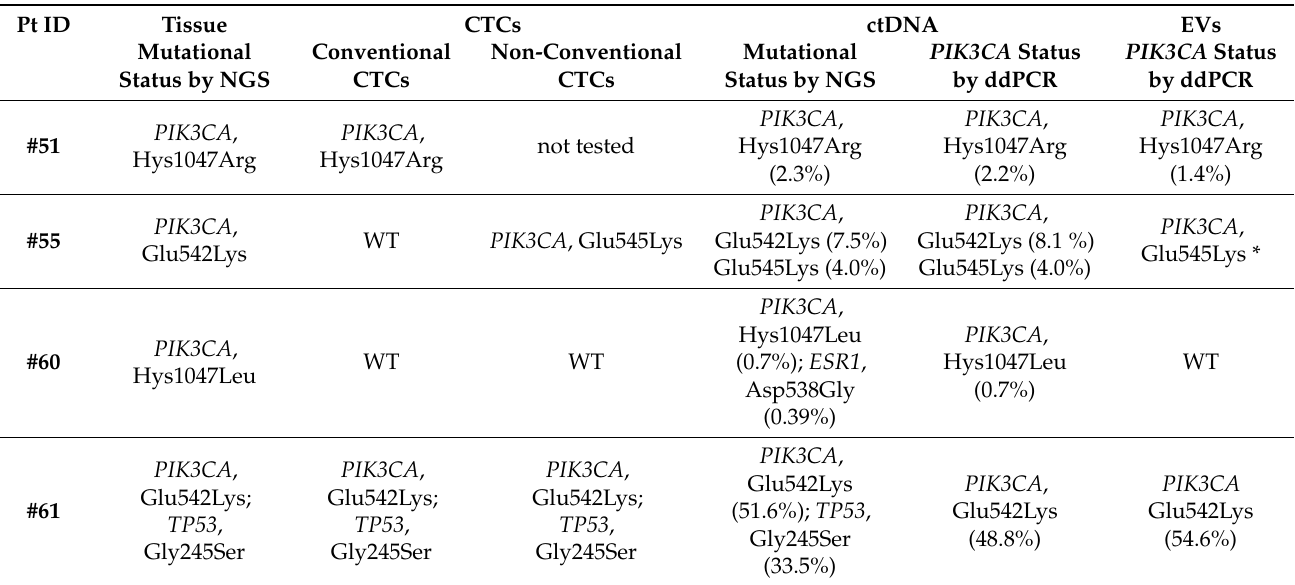
Table 2. Mutational status of the different circulating components in comparison with the correspond- ing tumor tissue.